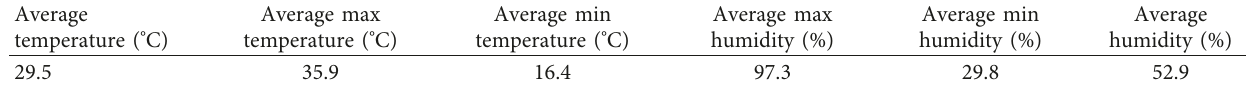
Table 1: Average temperature and humidity in the greenhouse during March and April 2018.